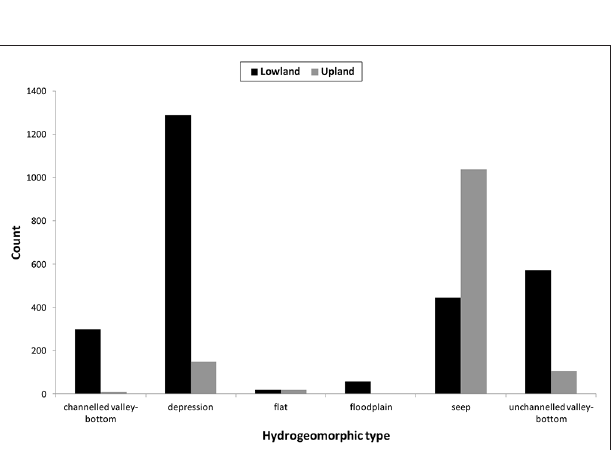
FIGURE 6 | Count of wetlands by HGM type for the Drakenstein municipality for upland vs. lowland